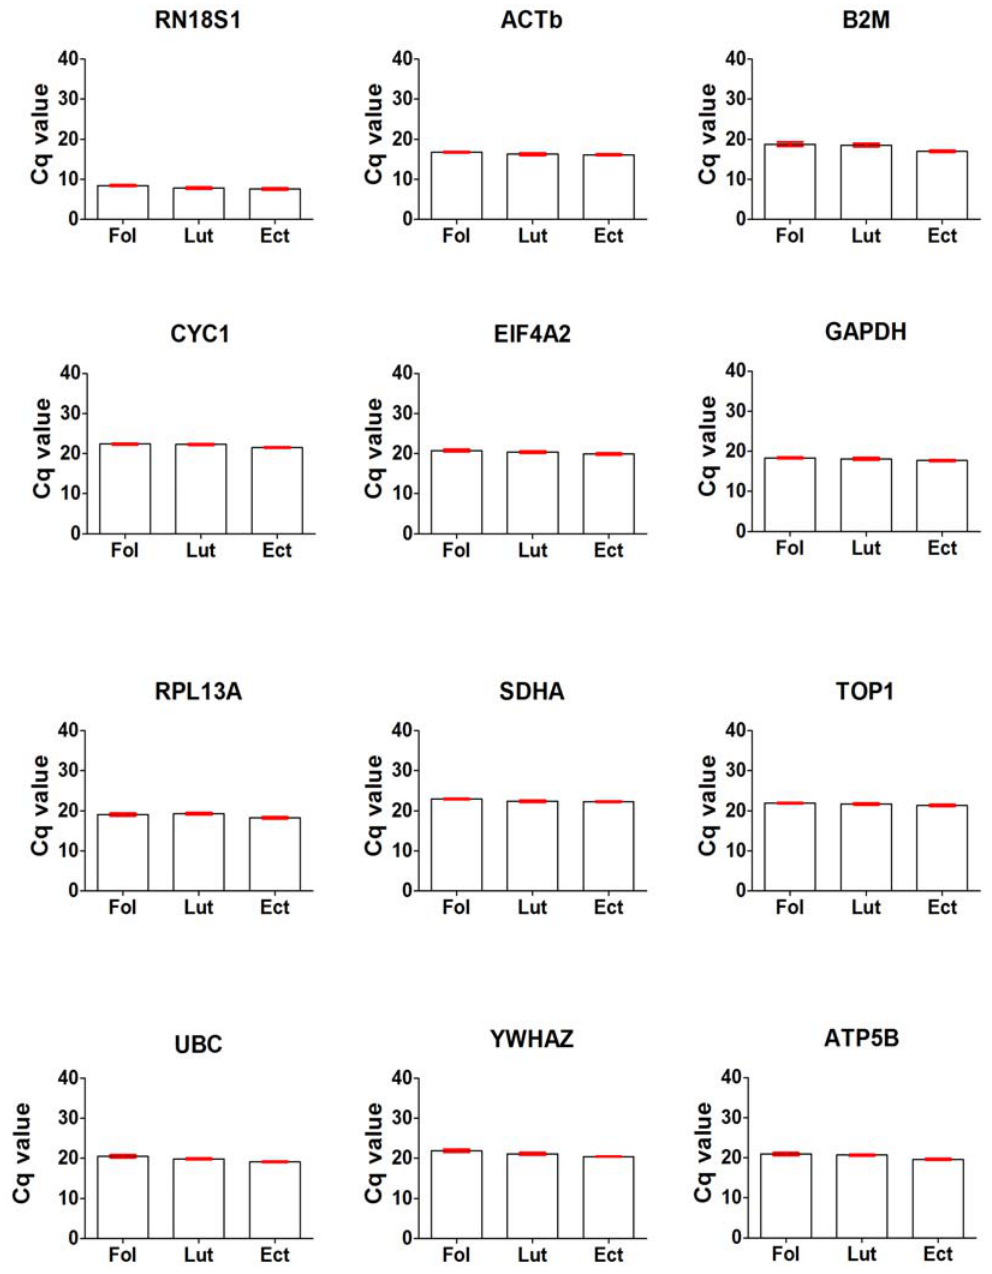
Figure 2. Expression levels of the 12 reference genes evaluated as shown by their Cq values in 12 endometrial samples. Samples were from the follicular (Fol, n = 4), luteal (Lut, n = 4) phase and ectopic pregnancy (Ect, n = 4). Cq values were obtained from the data output file of ABI PRISM 7000 and are inversely proportional to amount of mRNA template material